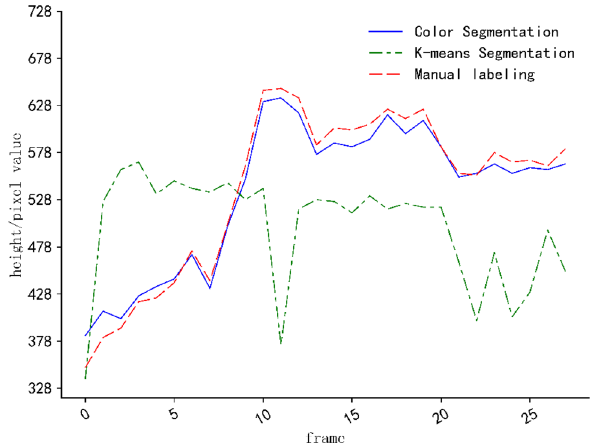
Fig. 9 Handheld camera height line trend chart